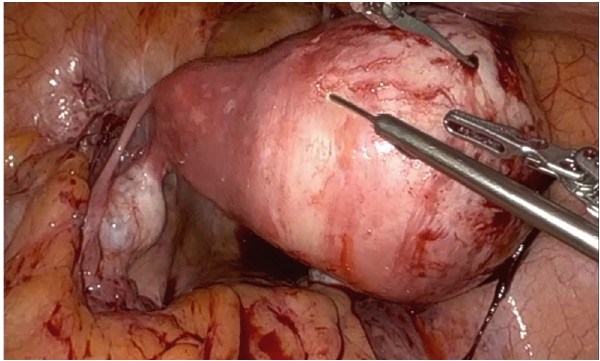
Figure 3: Intraoperative view of distended noncommunicating